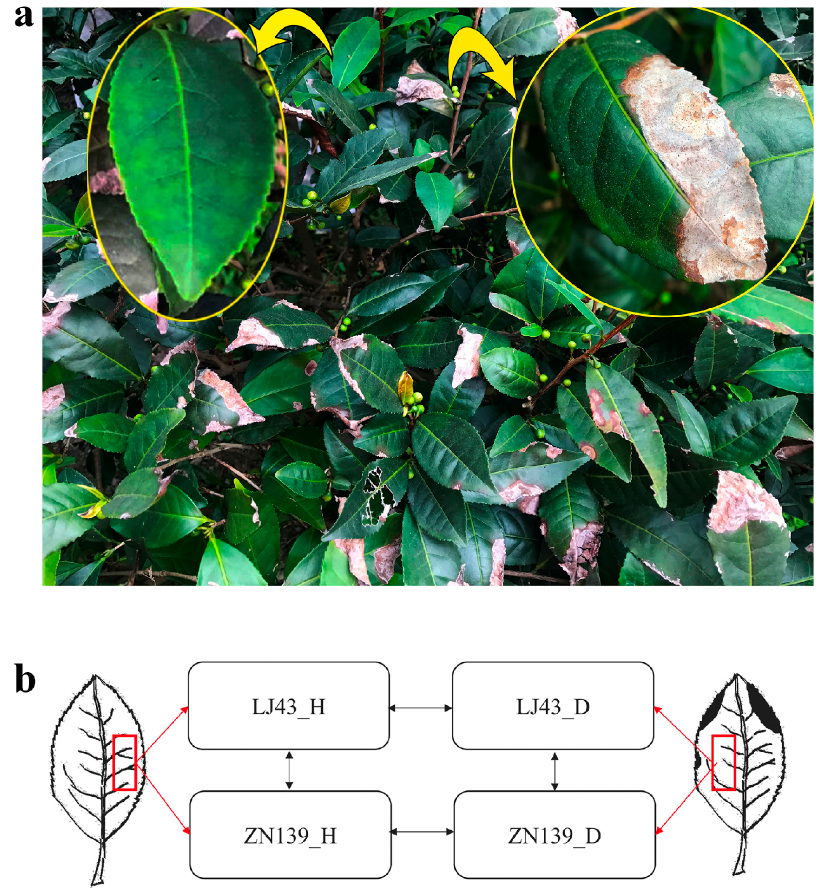
Figure 1. Sample preparation and experiment scheme. ( a ) Anthracnose of tea plant occurrence in tea field. Yellow arrow represents healthy leaf (left) and partially enlarged drawing of anthracnose infected leaf (right). ( b ) A schematic diagram of a healthy leaf (left) and an infected leaf (right). The leaf slices were cut for RNA isolation as described in red boxes. Pairwise comparisons for LJ43 and ZN139 were conducted by arrows. Horizontal arrows mean comparisons between healthy leaves (LJ43_H and ZN139_H) and anthracnose disease infected leaves (LJ43_D & ZN139_D) within cultivar, and the vertical arrow indicates comparisons between cultivars.